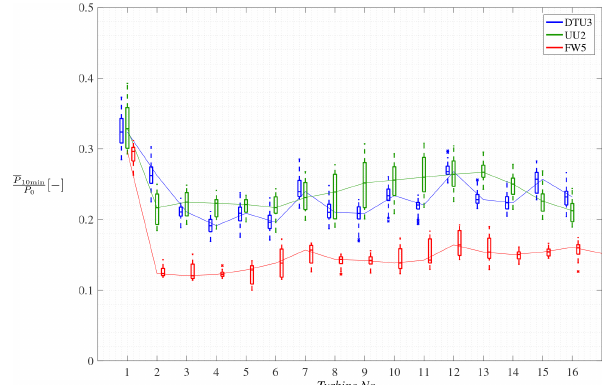
Figure 2. Box plots of the 10min averaged mechanical power production normalized by rated power P 0 of the first 16 turbines in DTU3, UU2 and FW5. All simulations have U 0 = 8ms − 1 , S X = 12 R and S Y = 20 R . The turbulence intensity is TI ≈ 15% for DTU3 and UU2, while it is TI ≈ 10% for FW5. Lines connect me- dian values of all turbines. Outliers not shown for